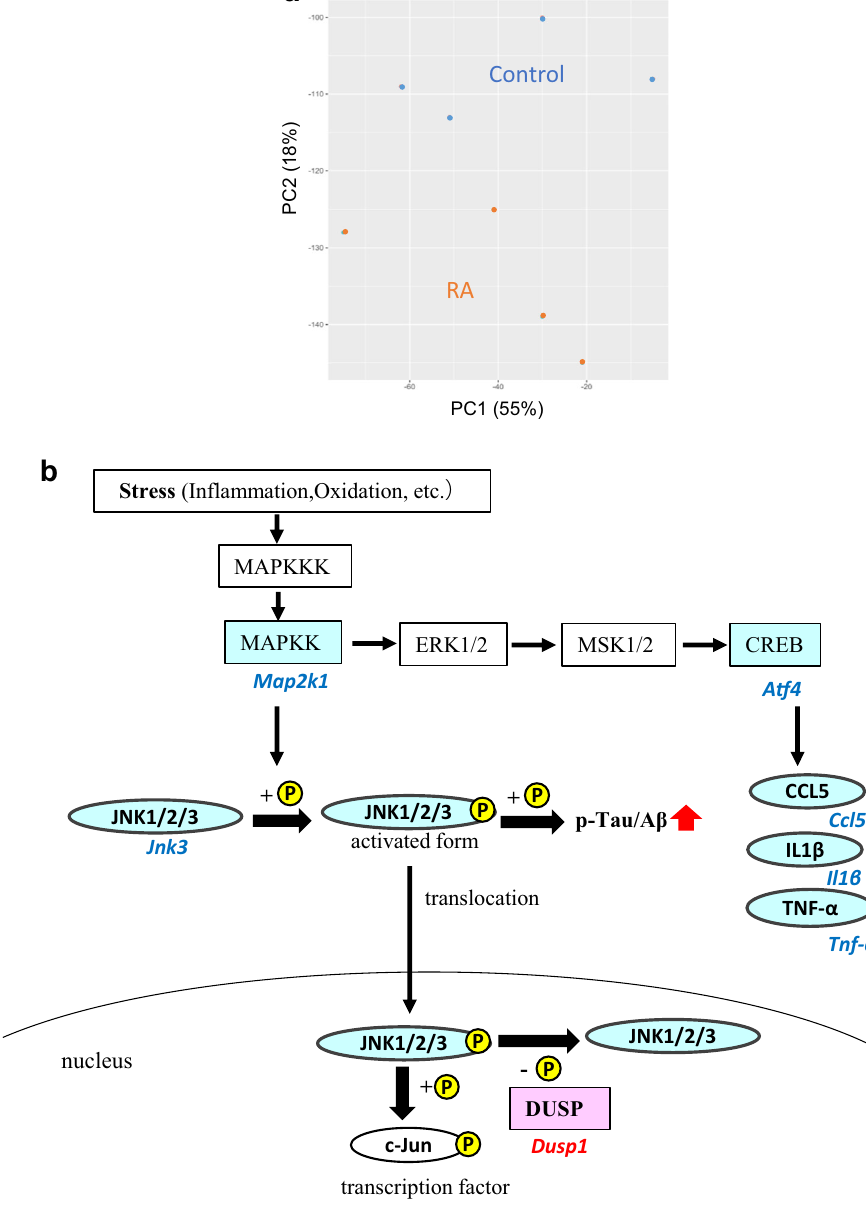
Fig. 4 Microarray analysis of changes in hippocampal gene expression. a Principal component analysis (PCA) shows that two distinct clusters in hippocampal gene expression. b The annotated differentially expressed genes (DEGs) of c-Jun N-terminal kinase (JNK) signaling, which related to in fl ammation and tau phosphorylation. The DEGs annotated with KEGG pathway of “ TNF signaling pathway ” are shown in an integrated MAPK/JNK pathway. Italicized and nonitalicized letters indicate genes and proteins, respectively. Red and blue letters indicate genes that are up- and downregulated,